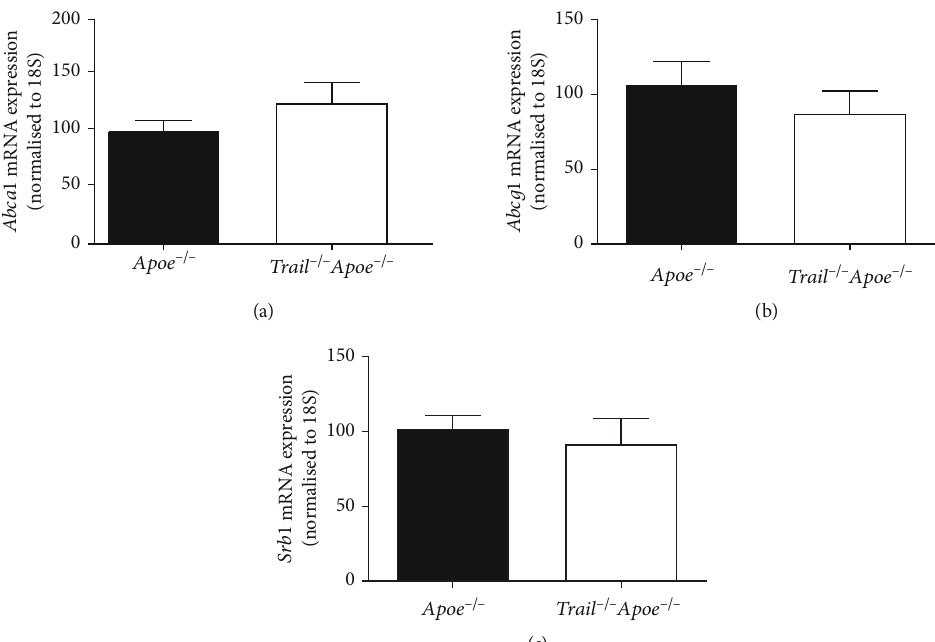
Figure 3: Expression of genes regulating cholesterol metabolism. Trail -/- Apoe -/- and Apoe -/- mice were fed a high-cholesterol diet for 12 weeks. The liver was assessed for (a) Abca1 , (b) Abcg1 , and (c) Srb1 mRNA expression. mRNA was extracted from the liver as described in Methods. mRNA expression of candidate genes was normalised to 18S ( n = 6 -7). Results are expressed as the mean ± SEM; Mann – Whitney t - test used in all conditions. Apoe: apolipoprotein E; TRAIL: TNF-related apoptosis-inducing